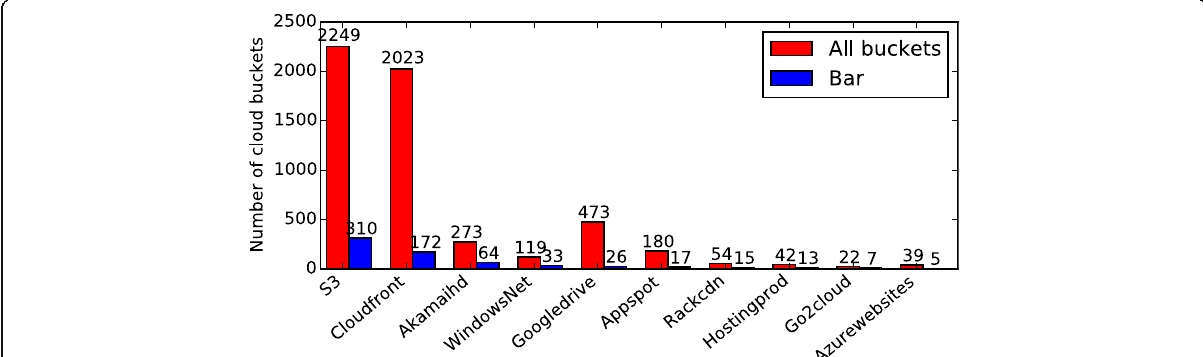
Fig. 5 Top 10 cloud platforms with most Bars, compared with their total number of cloud buckets in our